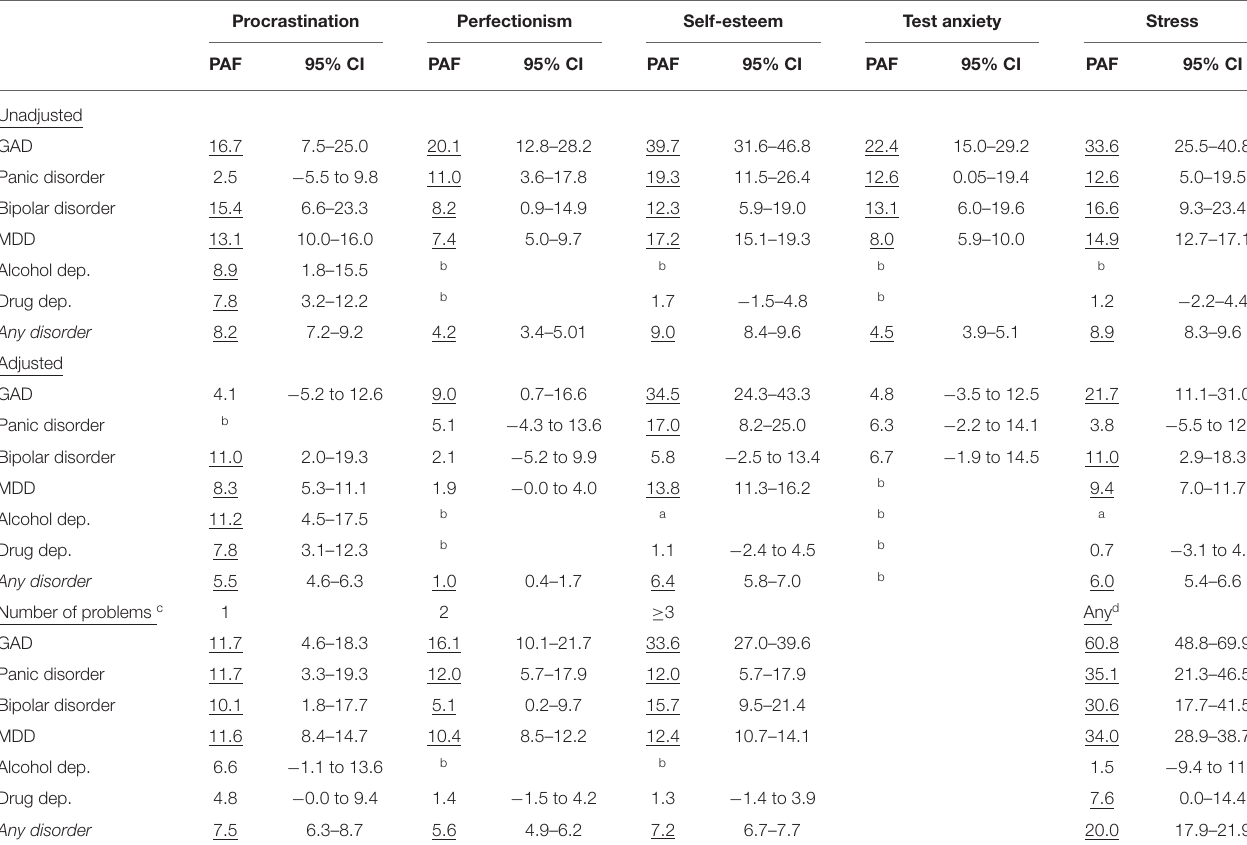
TABLE 4 | Population attributable fractions (PAFs) of mental disorders attributable to common psychological problems among university students (adjusted for the presence of other problems) a .